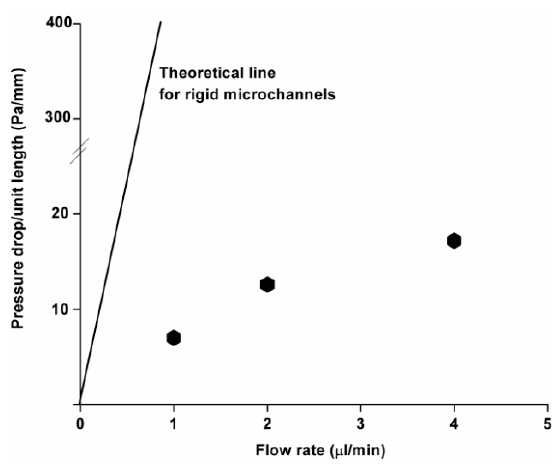
Figure 1. Experimentally and theoretically determined relationship between the channel pressure drop and imposed flow rate (FH4).